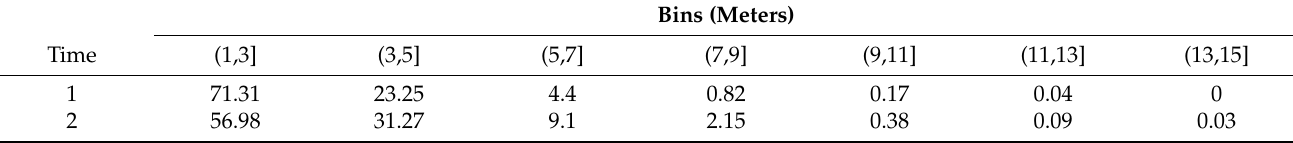
Table 8. Empty space radial distances measured for live healthy trees, all species, at time of plot establishment (Time 1) and at most recent assessment (Time 2) for the 11 plots combined. Bins open on the left side. Average bin size and frequency as % of total bin counts. The range of years between Times 1 and 2 was 7–15.